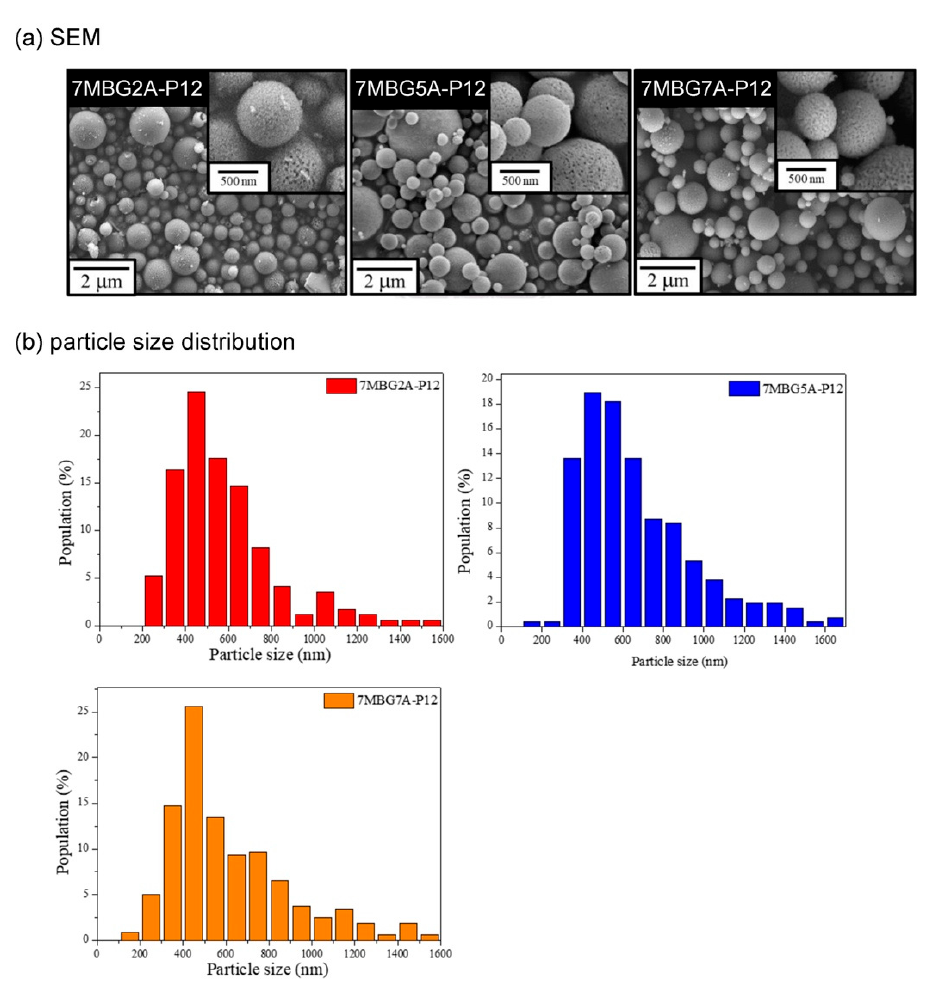
Figure 5. The FE- SEM images ( a ) and particle size distribution ( b ) of MBG adding different concen- trations of CH 3 COOH.